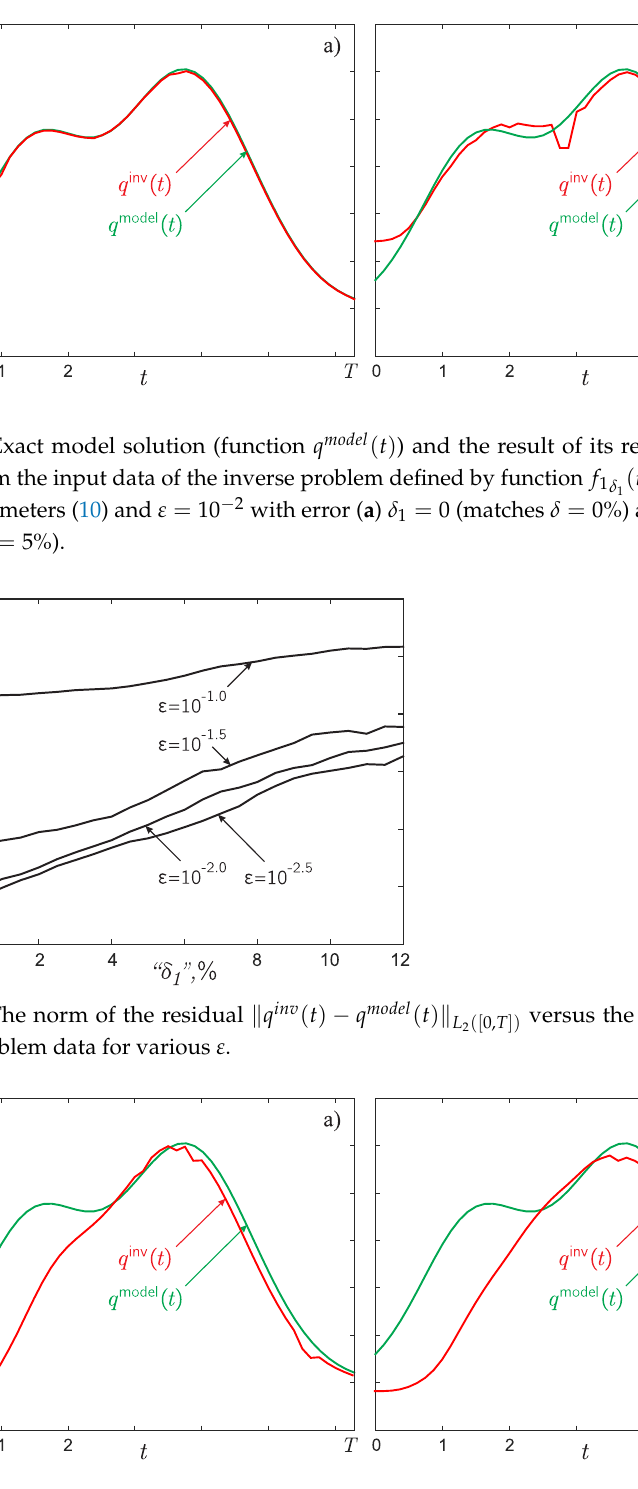
Figure 6. Exact model solution (function q model ( t ) ) and the result of its reconstruction (function q inv ( t ) ) from the input data of the inverse problem defined by function f 1 model parameters (10) and ε = 10 − 1 with error ( a ) δ 1 = 0 (matches δ = 0%) and ( b ) δ 1 ∼ 3.5 × 10 − 2 (matches δ =